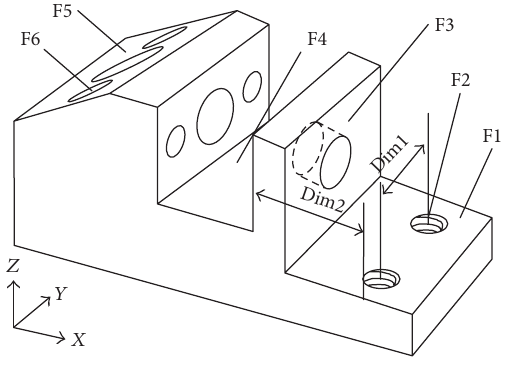
Figure 2: An example